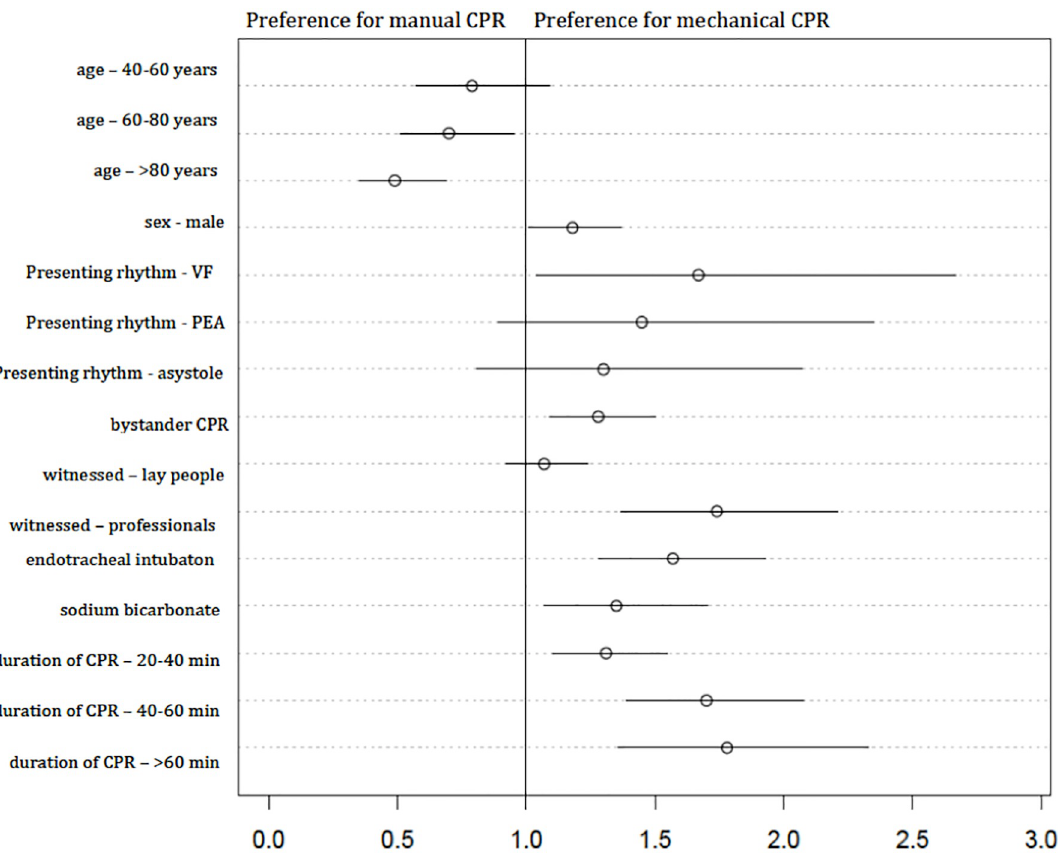
PLOS ONE | https://doi.org/10.1371/journal.pone.0208113 January 2,